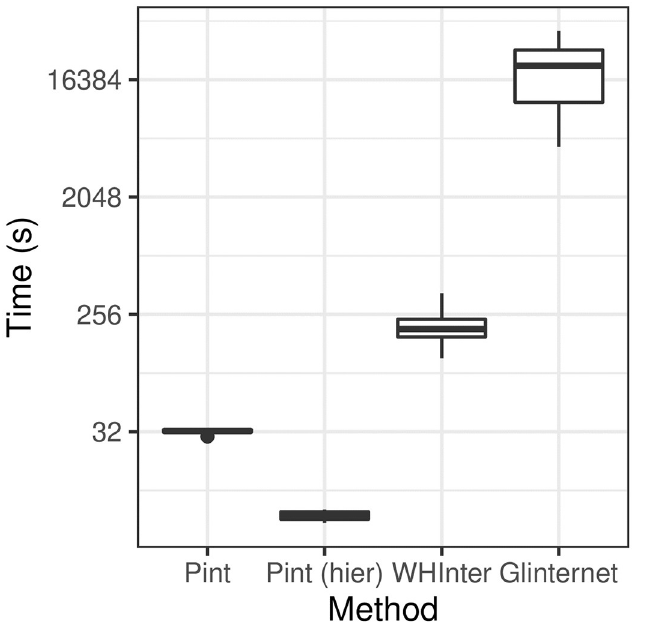
Fig 5. Running times for each method using large p = 4, 000 data sets. Note that time is shown on a log scale.